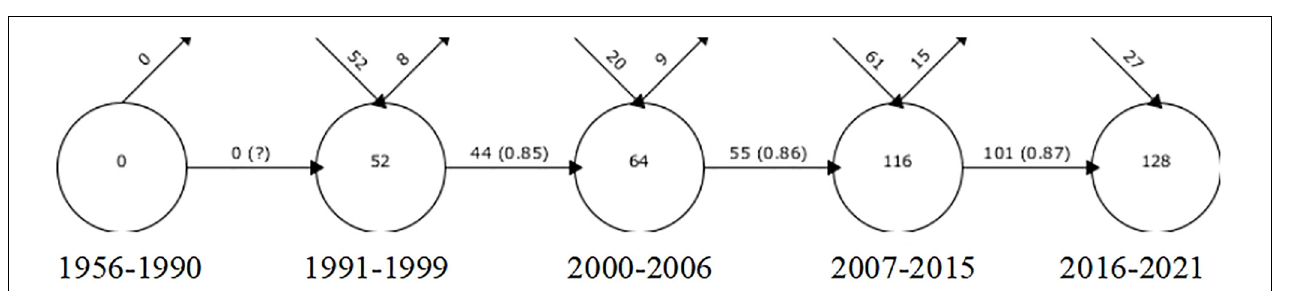
FIGURE 2 | Overlapping